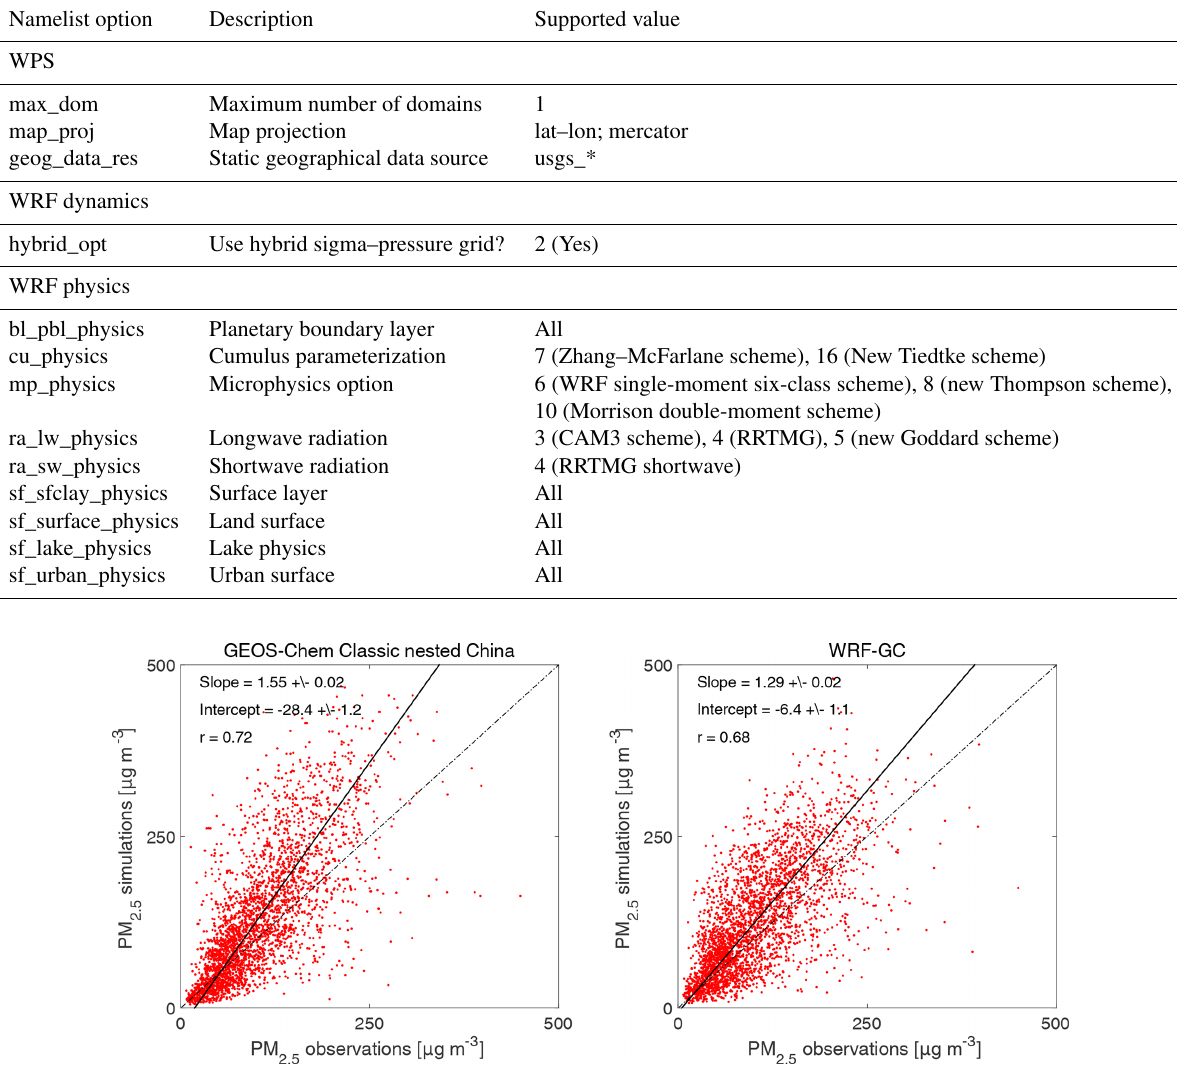
Figure 3. Scatter plots of observed and simulated daily mean PM 2 . 5 during 22 to 27 January 2015 at 507 surface sites over eastern China for (a) the GEOS-Chem Classic nested-China simulation and (b) the WRF-GC nudged simulation. The solid lines indicate the reduced major-axis regression lines, with slopes, intercepts, and correlation coefficients ( r ) shown in the inset. The dotted lines indicate the 1 : 1